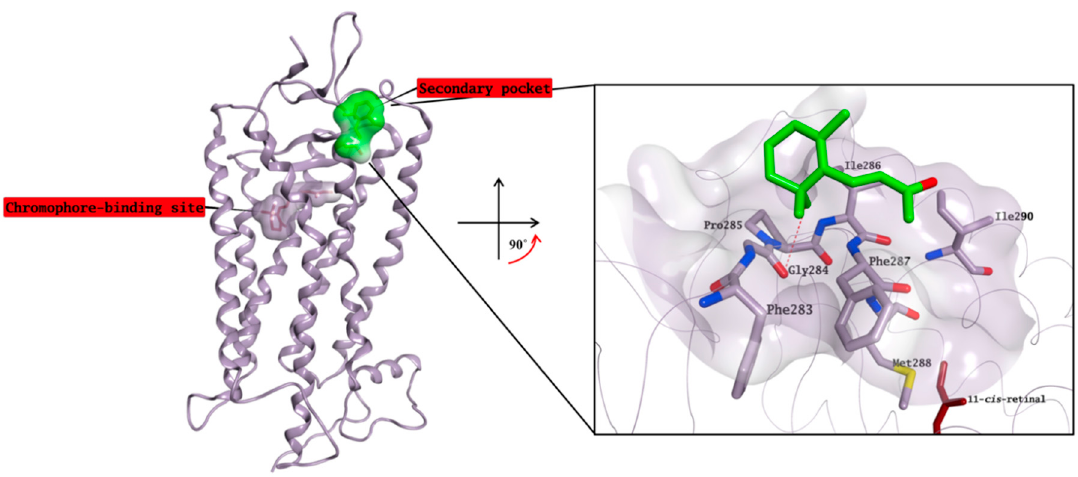
Figure 11. Crystal structure of β -ionone (carbon atoms in green) in complex with rhodopsin in which the chromophore-binding pocket is already occupied by 11- cis -retinal (carbon atoms in garnet). β -ionone is bound to a small, surface-exposed and highly hydrophobic pocket. The binding site area is represented as the molecular surface. Rhodopsin is represented as the lilac ribbon. On the binding site cut out rhodopsin is represented as a lilac tube for clarity.